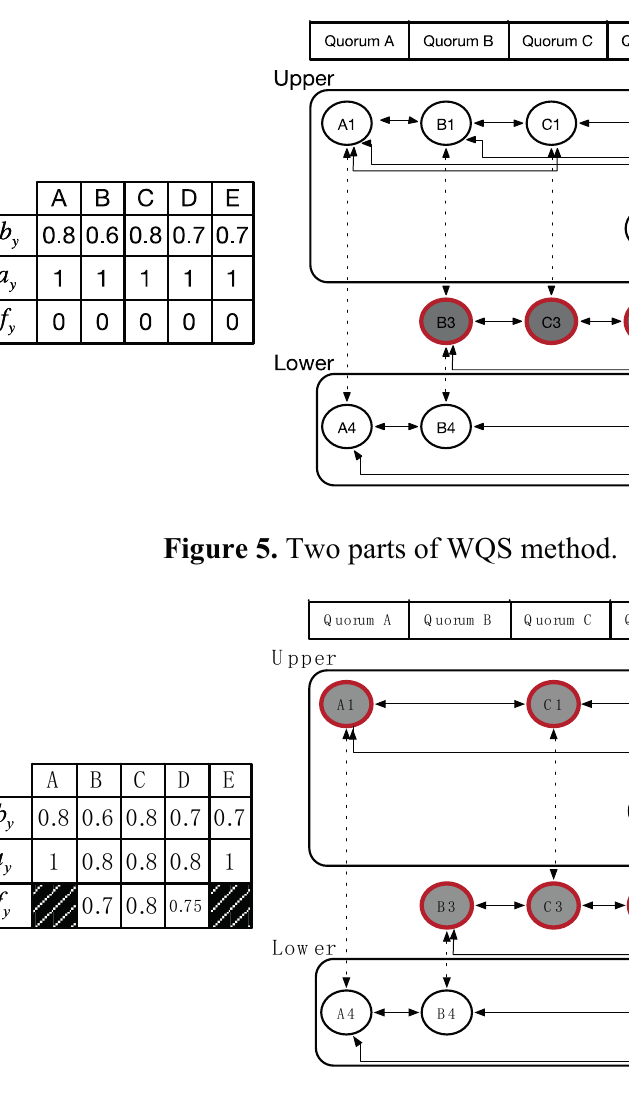
Figure 6. Decision result in the WQS